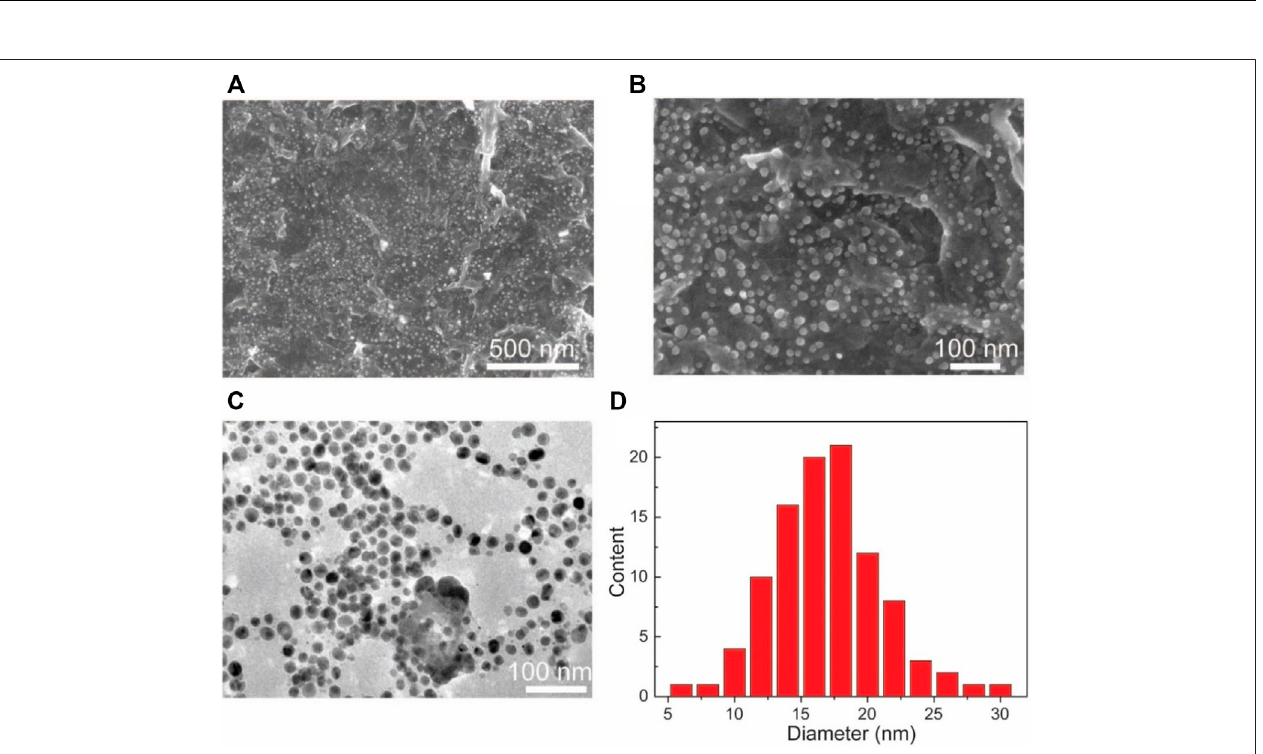
FIGURE 3 | (A,B) SEM based images of Au NPs-PDA-PAA-graphene with varying magni fi cation (C) TEM image of Au NPs-PDA-PAA-graphene (D) Size and distribution of Au nanoparticles in statistics.